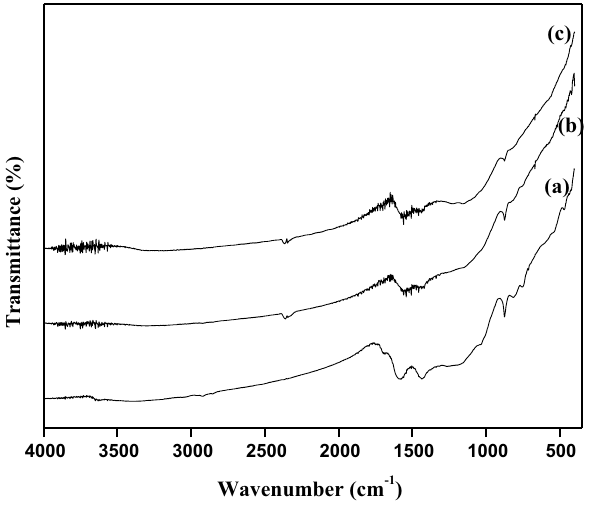
Fig. 7 FTIR spectrum of a pure PsLw carbon b PsLw